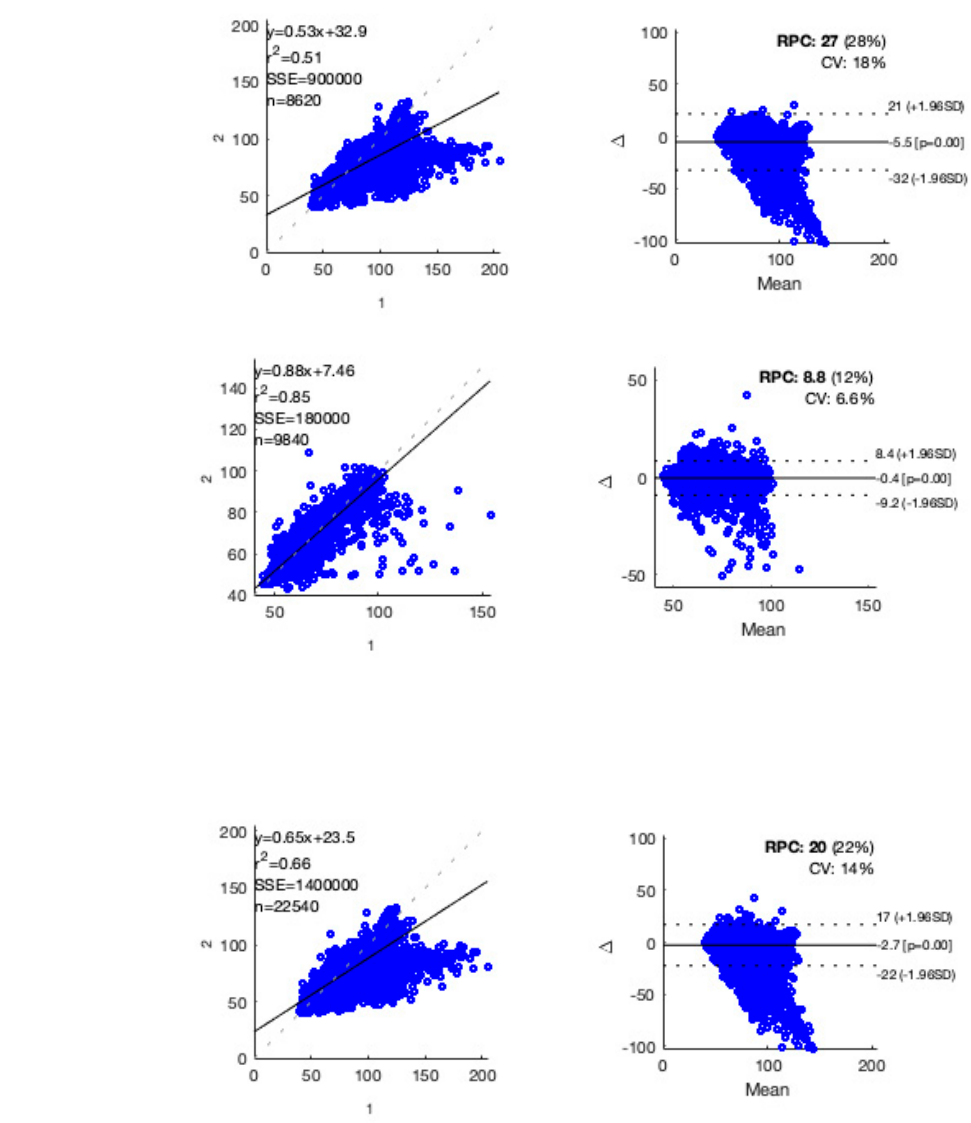
Figure A1. ( a – c ) The accuracy of heart rate estimation by the medical wearable compared to ECG was calculated by using the Spearmen correlation (left figure). Additionally, a Bland–Altman graph was plotted with 95% LoA (Limits of Agreement) (right figure). Automated ECG processing was performed using an open-source algorithm (Sedghamiz H. Complete Pan Tompkins Implementation ECG QRS detector. In: MATLAB Central File Exchange 2019.).